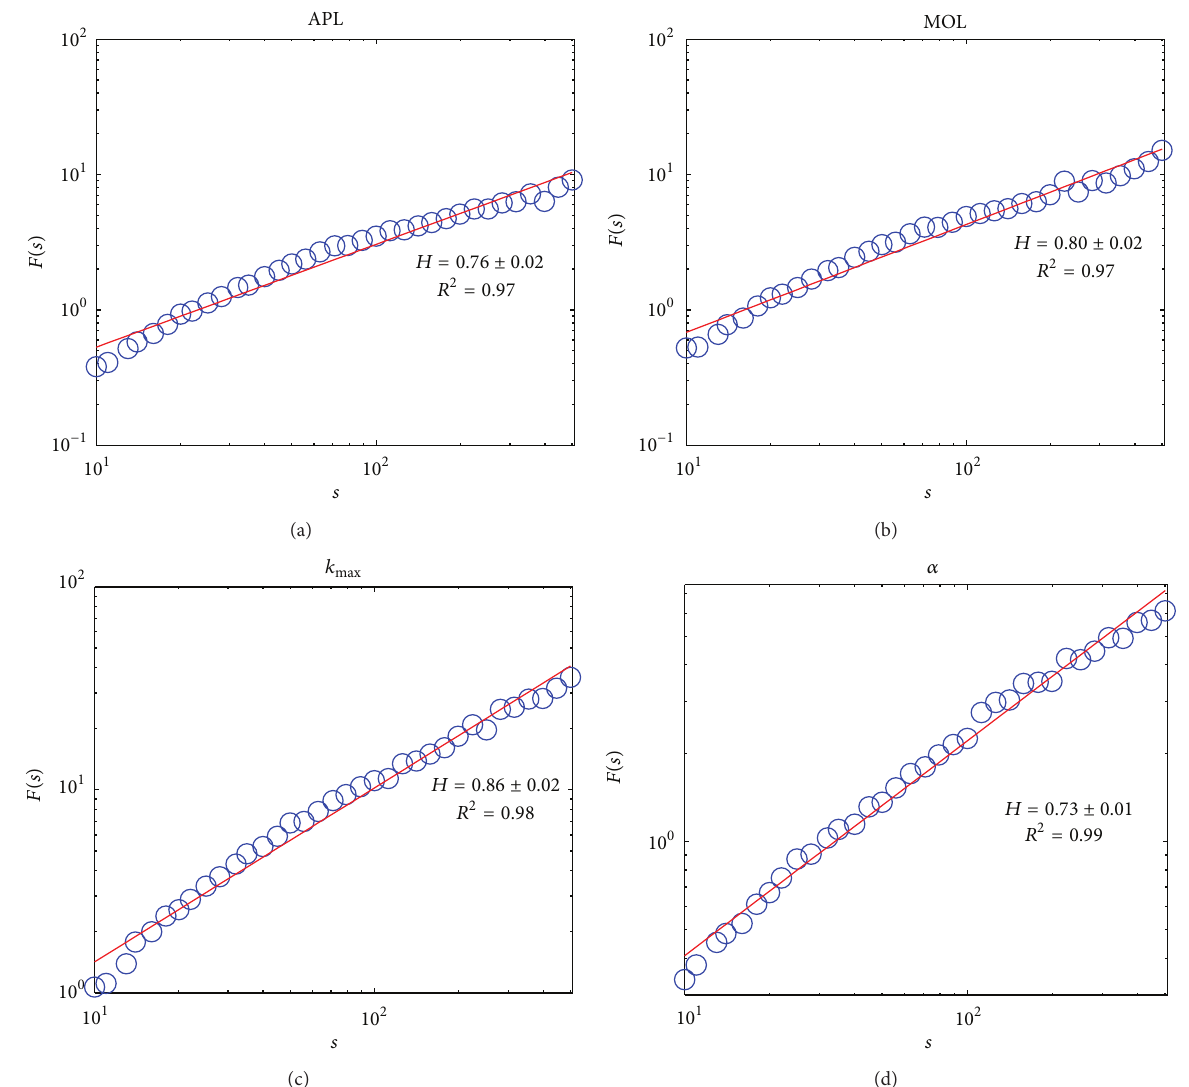
Figure 8: The DFA functions of the average path length (APL), mean occupation layer (MOL), and maximum degree 𝑘 max and the estimated power-law exponent 𝛼 on log-log plots. In each panel, the red solid line stands for the corresponding linear fitting curve, and the estimated Hurst exponent 𝐻 and its corresponding coefficient of determination 𝑅 2 are presented. The Hurst exponent 0.5 < 𝐻 < 1.0 implies that the time series is long-range correlated or has a long-term